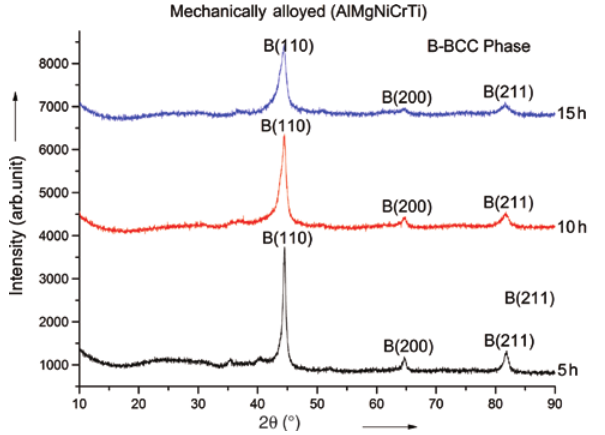
Figure 1: XRD patterns of AlMgNiCrTi HEA powder during different milling times.